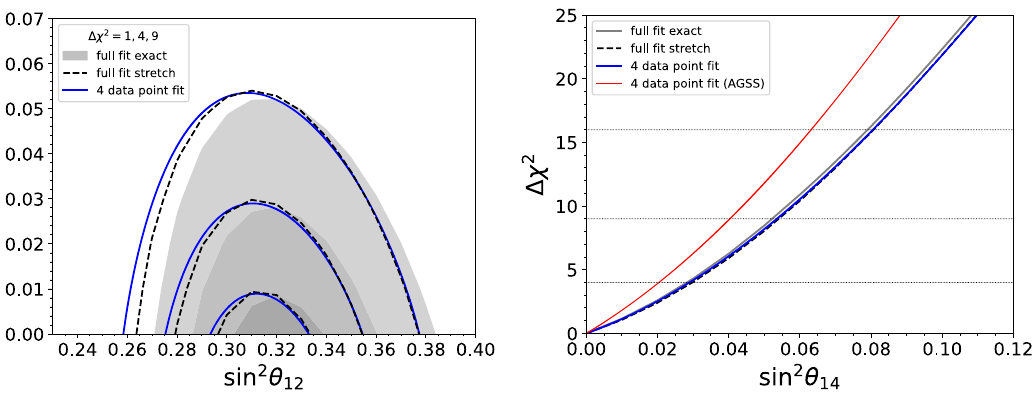
Fig. 2 Results for the GS98 solar models. We compare the exact solar neutrino fit (grey), the full solar fit but using the “stretch” parameteri- zation for the probabilities from Eq. (2.9) (black-dash), and our 4-data